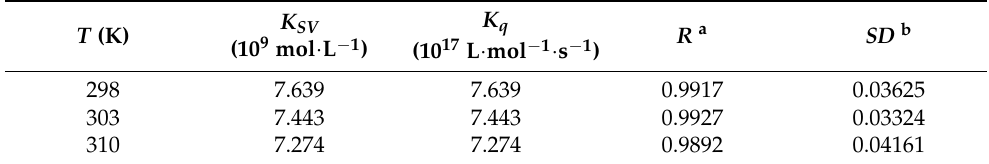
Figure 2. ( A ) The fluorescence spectra of HSA in the absence and presence of different concentrations of AgNPs; ( B ) Stern–Volmer plots for the HSA–AgNPs system at varying temperatures. The concentration of HSA was 1.0 × 10 − 6 M with the concentrations of AgNPs being (1–11): 0–1.0 × 10 − 10 M. Table 1. Ster–Volmer quenching constants of AgNPs and HSA at varying